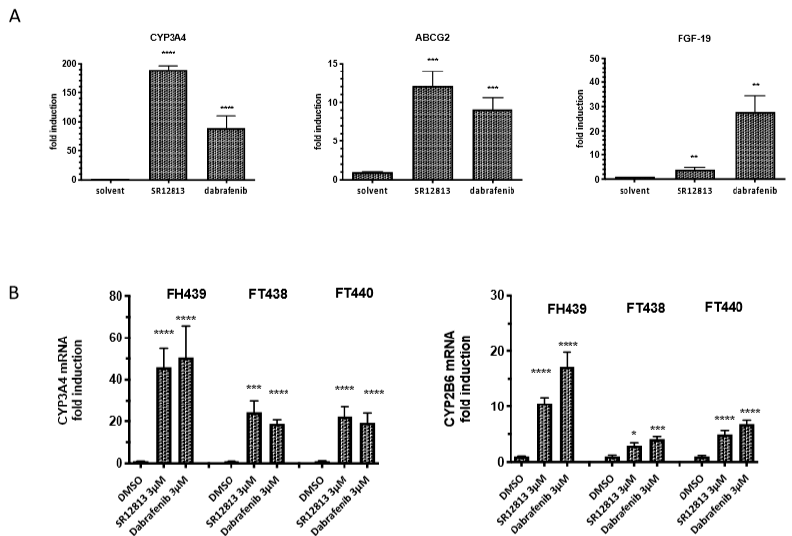
Figure 5. Effects of dabrafenib on hPXR target genes expression in LS174T-hPXR cells and in primary